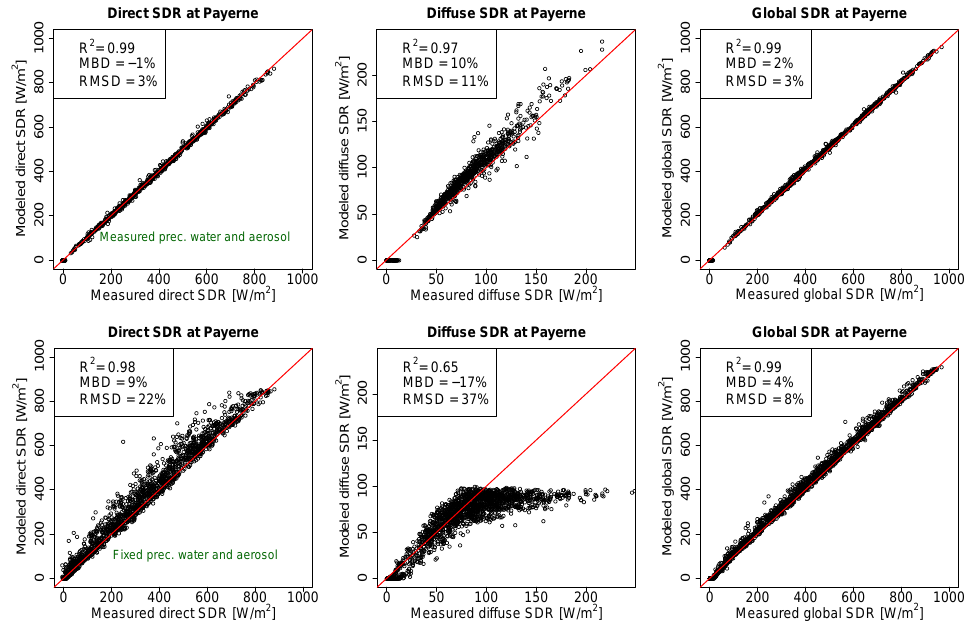
Fig. 4. Scatter plots of direct, diffuse and global SDR at Payerne. The top figures result from a model experiment when using measurements of the precipitable water and aerosol content. The lower figure show the model results when the atmospheric parameters have fixed values. The solid red line indicates the perfect